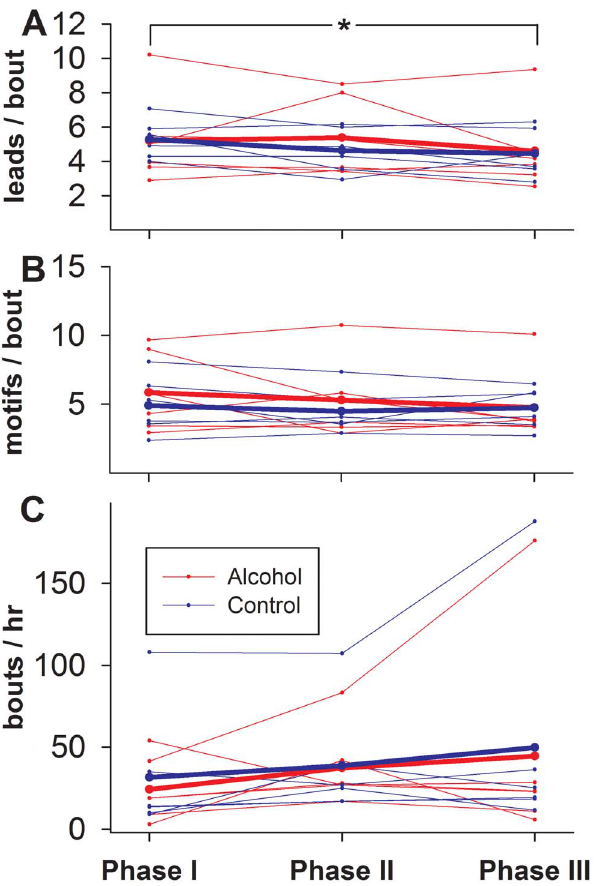
Fig. 3. Effect of alcohol drinking on singing behavior. Plotted are the individual and treatment group means of (A) number of lead notes per bout, (B) the mean number of motifs within a bout and (C) the mean number of bouts per hour across Phases for birds that received alcohol (red) in Phase III and for controls (blue). Small symbols connected by dotted lines represent individual bird means, while large symbols connected by solid lines represent the treatment groups. An * indicates a significant change across phases for both the control and alcohol treatments, combined.